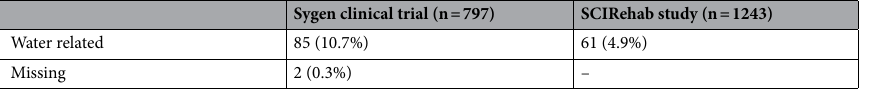
Table 1. Demographics and injury characteristics of the included cohorts. *American Spinal Injury Association Impairment Scale (AIS): AIS-A, no sensory or motor function is preserved in the sacral segments S4-5. AIS-B, sensory but no motor function is preserved below the neurological level and includes the sacral segments S4-5 (LT or PP at S4-5 or DAP), and no motor function is preserved more than three levels below the motor level on either side of the body. AIS-C, motor function is preserved at the most caudal sacral segments for voluntary anal contraction OR the patient meets the criteria for sensory incomplete status, and has some sparing of motor function more than three levels below the ipsilateral motor level on either side of the body. Less than half of key muscle functions below the single NLI have a muscle grade ≥ 3. AIS-D, motor incomplete status as defined above, with at least half (half or more) of key muscle functions below the single NLI having a muscle grade ≥ 3. AIS-E, if sensation and motor function as tested with the ISNCSCI are graded as normal in all segments, and the patient had prior deficits, then the AIS grade is E. Someone without an initial SCI does not receive an AIS